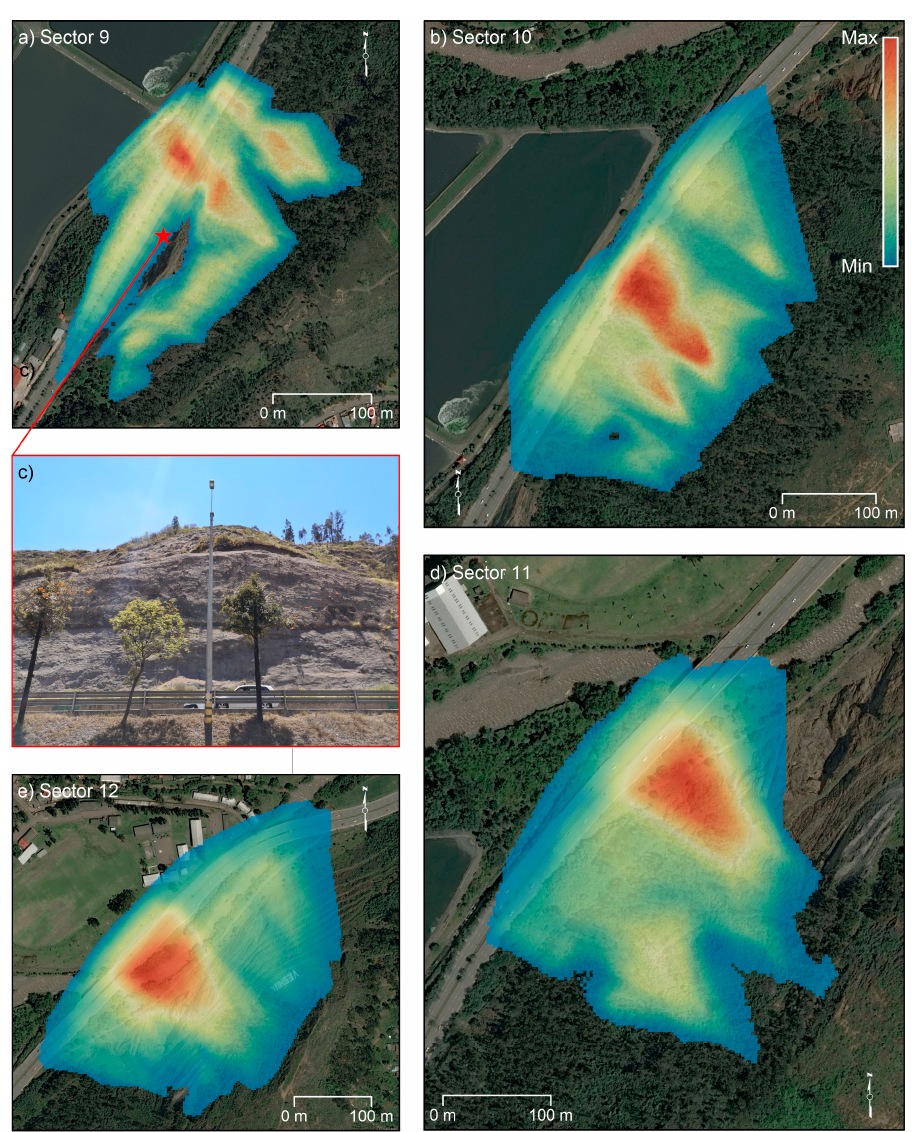
Figure 10. Outcomes of QPROTO algorithm for sector n ◦ 9 ( a ), 10 ( b ), 11 ( d ), 12 ( e ) with different classes of potential rockfall runout occurrences; picture ( c ) shows the slopes prone to collapse for sector 9.